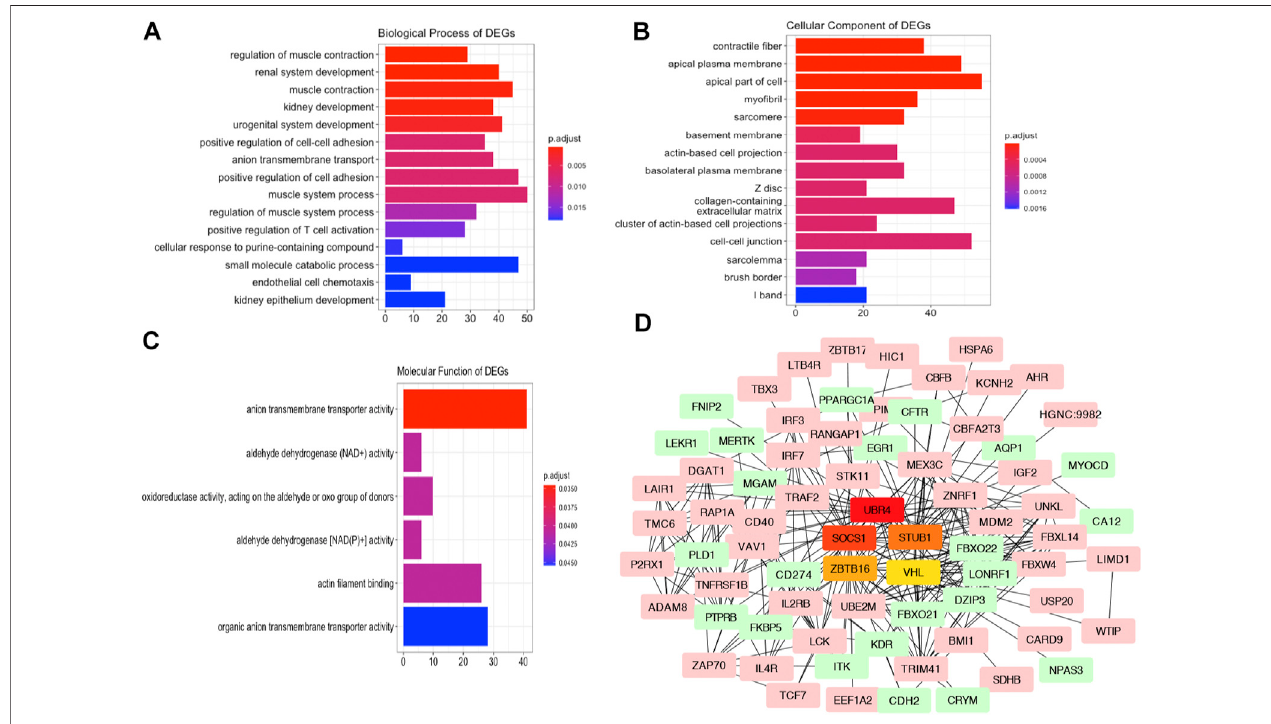
FIGURE4 | GO Analysis and PPInetworkofthe altered genes. Plots of theenriched GO terms including theBP (A) , CC (B) , and MF (C) .The x -axis represents the number of genes in the enriched GO terms. (D) Interaction network analysis of DEGs. Pink and green genes represent upregulated and downregulated DEGs. Five hub genes are visualized in the center of the PPI